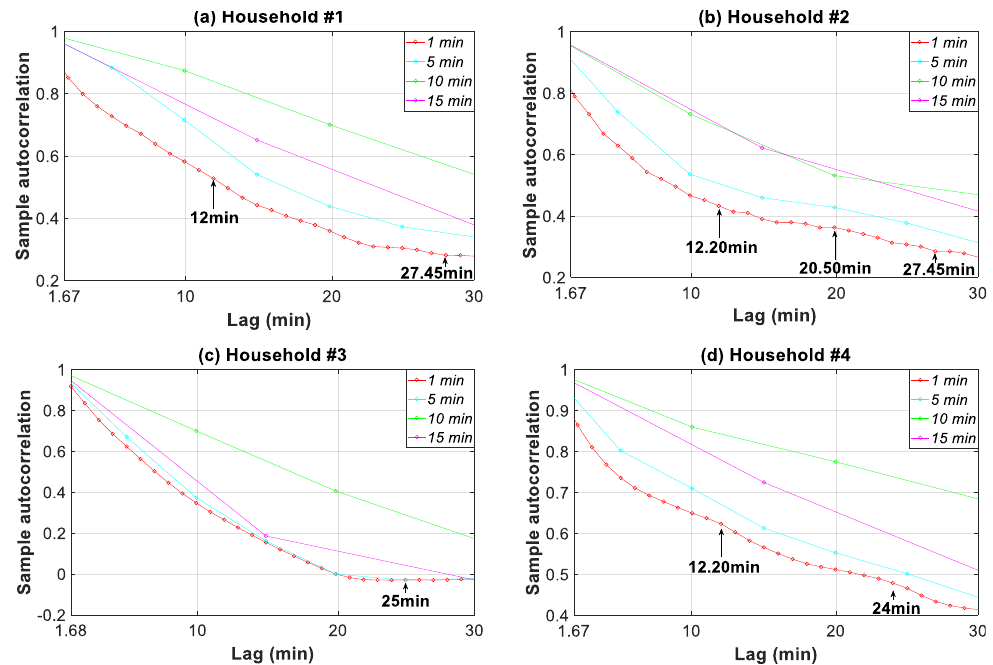
Figure 16. Periodogram of the consumption load profile for households #1 to #4: 1.66–30 min time slice.